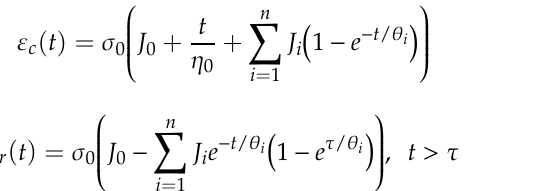
Figure 14. tan( δ ) of starch-beet pulp foams at different RH conditions.